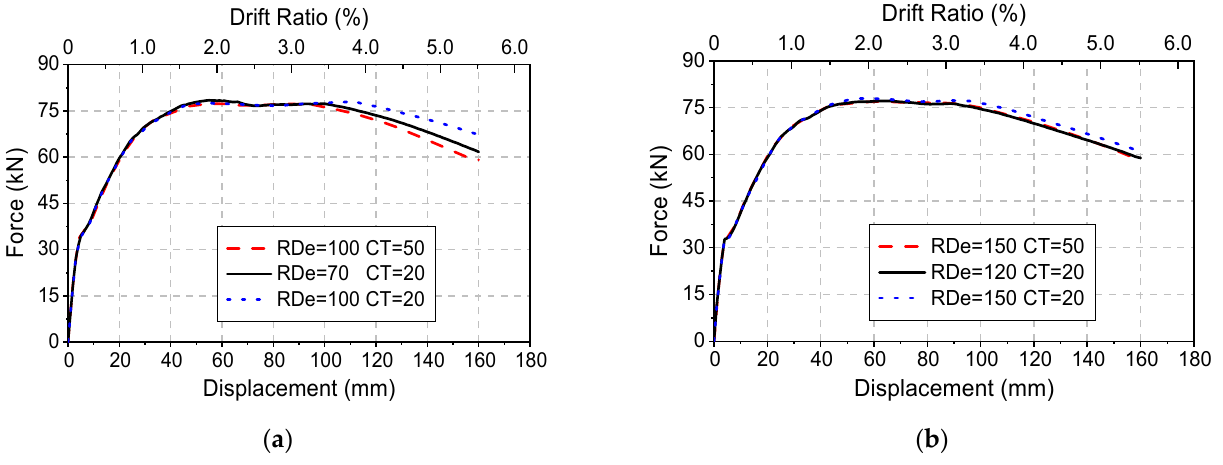
Figure 23. Force–displacement relation of different cushion thicknesses: ( a ) shallow recess; ( b ) deep recess.